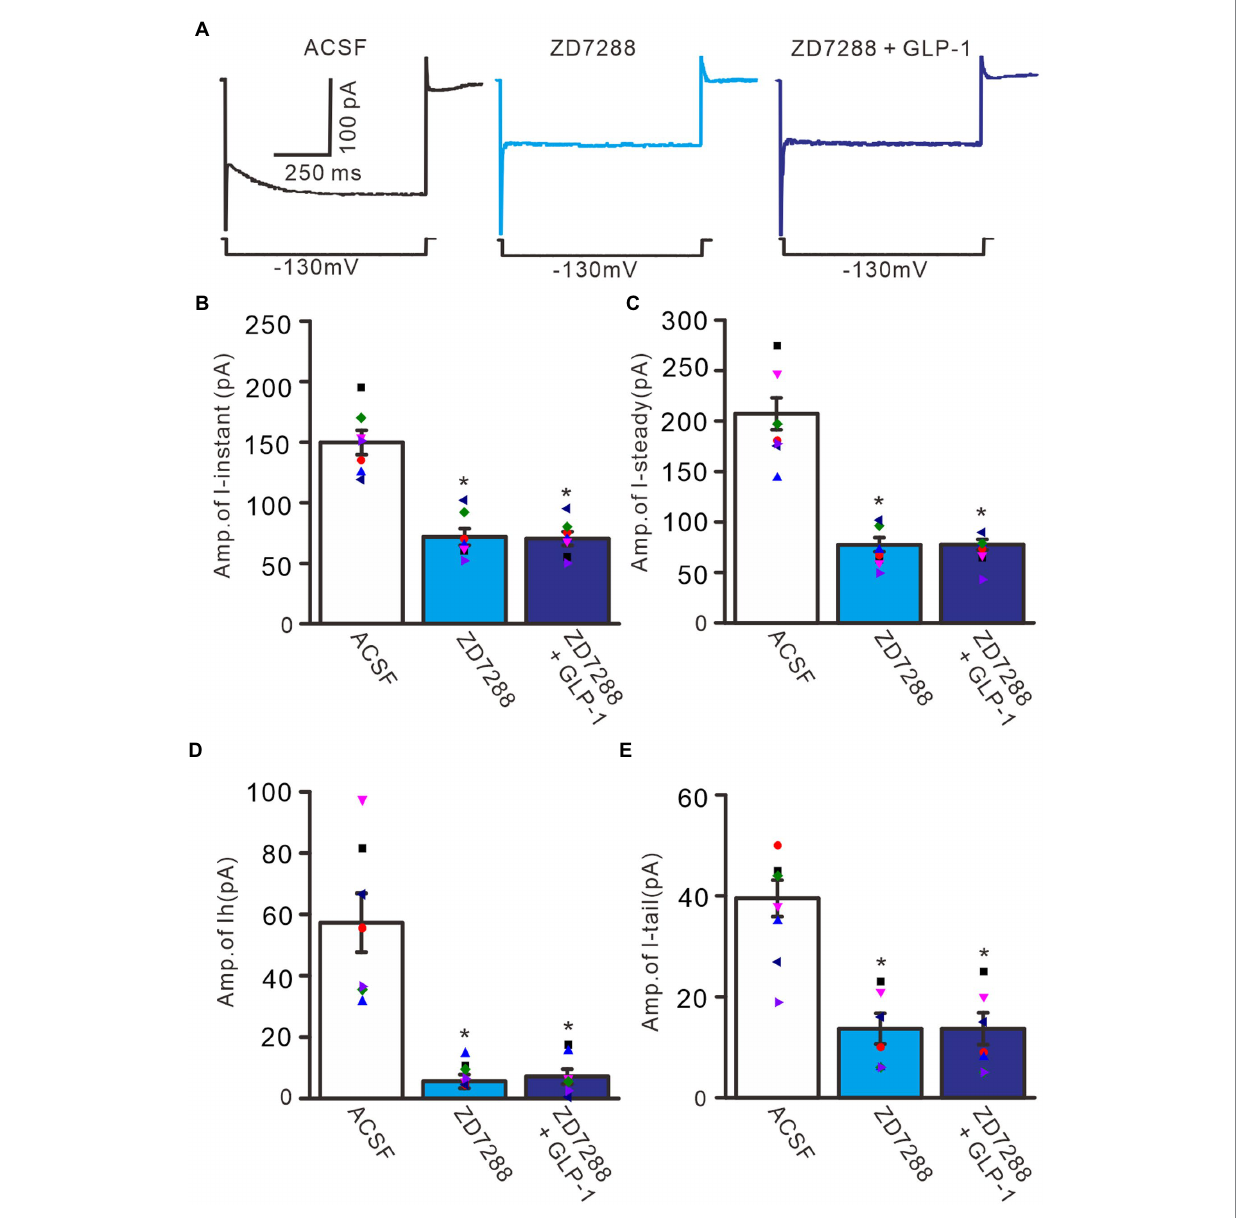
FIGURE 6 Blockade of IH abolished the effect of GLP-1 on membrane currents in PCs. (A) Under voltage-clamp recording mode (Vh = − 60 mV), the representative traces showing membrane currents elicited by hyperpolarizing voltage steps ( − 130 mV, 1 s) during treatments of ACSF (control), ZD7288 (50 μ M), and ZD7288 + GLP-1. (B,C) Bar graphs show that the mean (± S.E.M) and individual amplitude of I-instant (I-inst.; B ) and I-steady (C) during treatments with ACSF, ZD7288 (50 μ M), and ZD7288 + GLP-1. (D,E) Bar graphs show that the mean (± S.E.M) and individual amplitude of IH (D) and IT (E) during each treatment. * p < 0.05 vs. ACSF, n = 7 cells in each